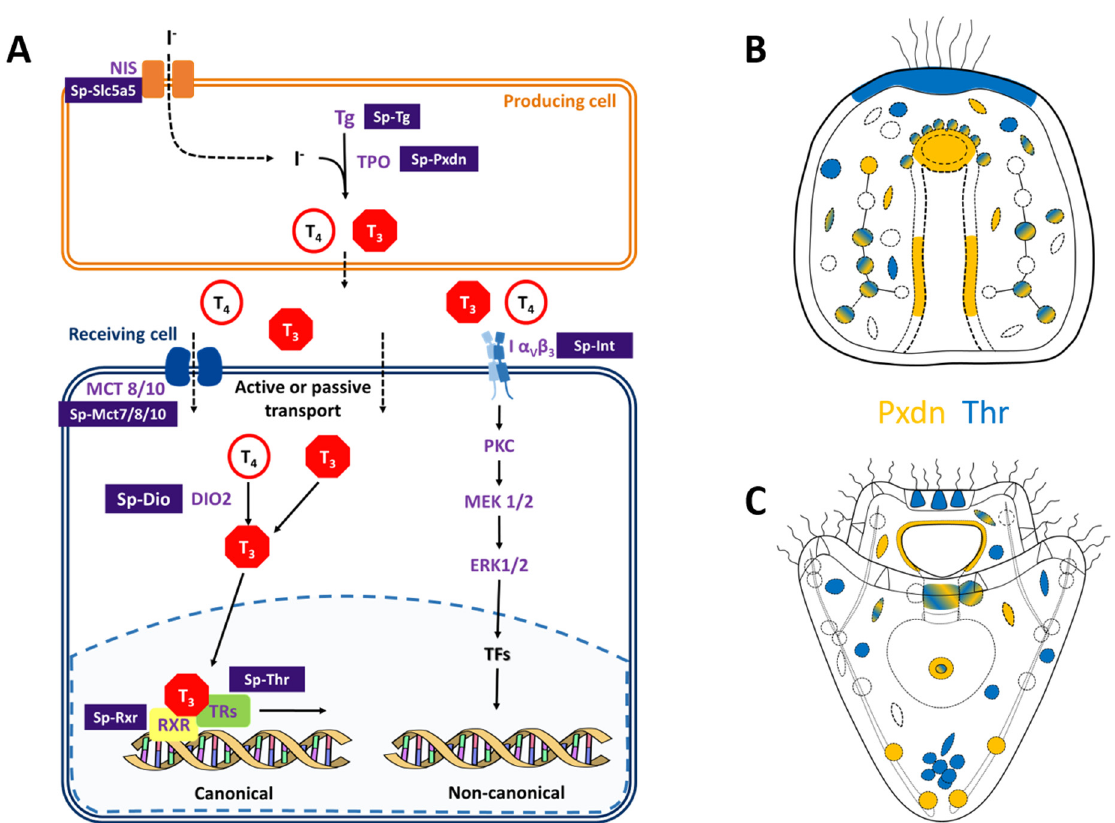
Figure 3. Identification of the THs pathway components in sea urchin genome and identification of putative producing (orange) and/or receiving (blue) cells in sea urchin embryo and pluteus larva. ( A ) Scheme summarizing the data reported in this study. The scheme includes both the canonical and non-canonical integrin-mediated transduction cascades activated by the THs. Names in purple indicate genes belonging to the vertebrate pathway that have homologs in the sea urchin S. purpuratus genome. Purple boxes contain the proposed names for the sea urchin homologs of the genes involved in the main TH pathway. ( B , C ) Schematic representation of the expression patterns of Sp-Pxdn (orange), indicative of a producing cell and Sp-Thr (blue), indicative of a receiving cell. at gastrula ( B ) and pluteus ( C ) stages. Color-code is the same as shown in ( A